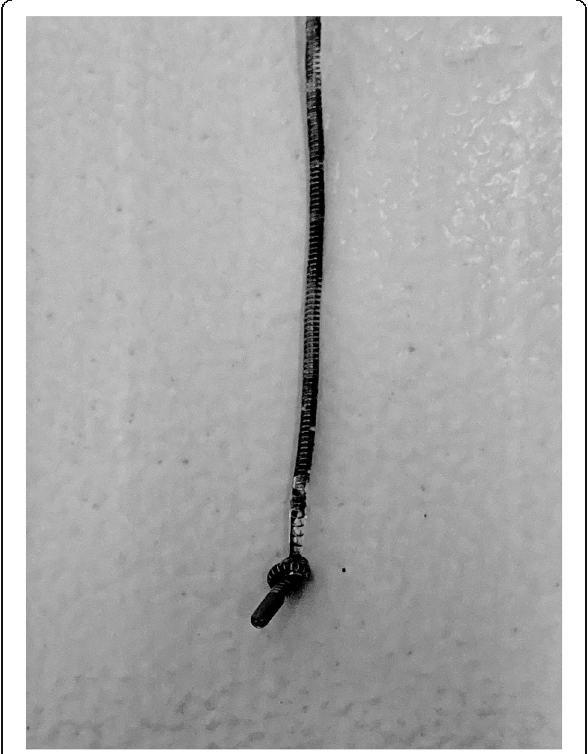
Fig. 1 Removed epidural catheter. A knot was formed at about 3 mm from the